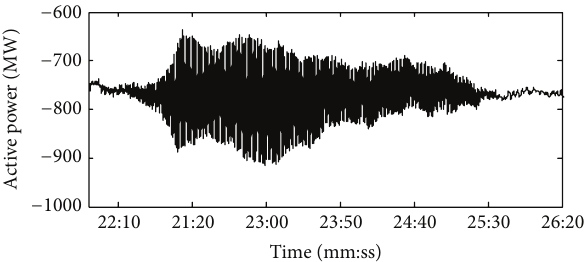
Figure 7: The active power oscilloscope record of the second Long- Dou tie